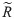
Dependence on the parameters of the competitor.Each new parameter of the system is increased along the x axis. Toxic protein concentration peak fold-increase R˜ is plotted on the y axis for each run corresponding to the value the new parameter takes on. The default or fixed values of the parameters are the same as in Fig 7.